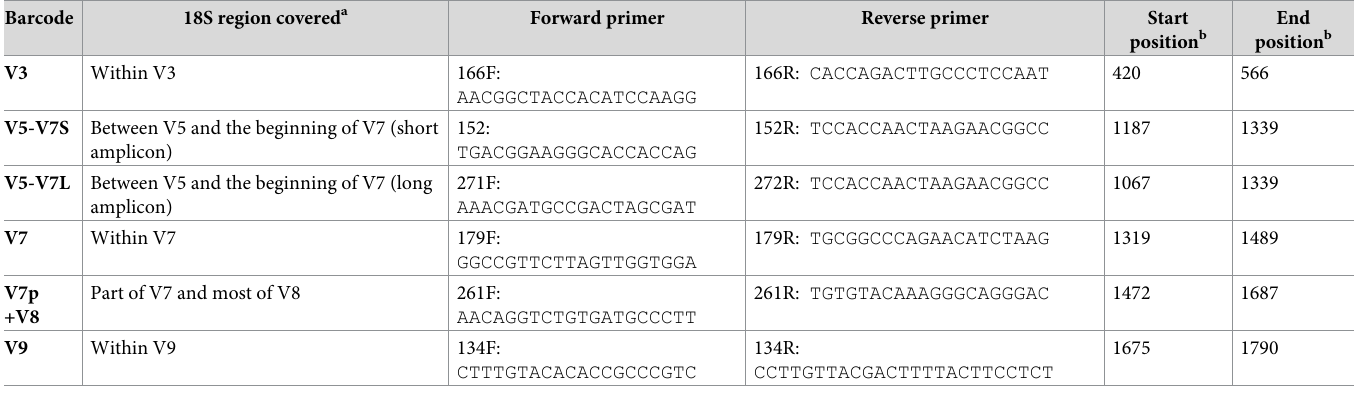
Table 1. Barcodes used in this